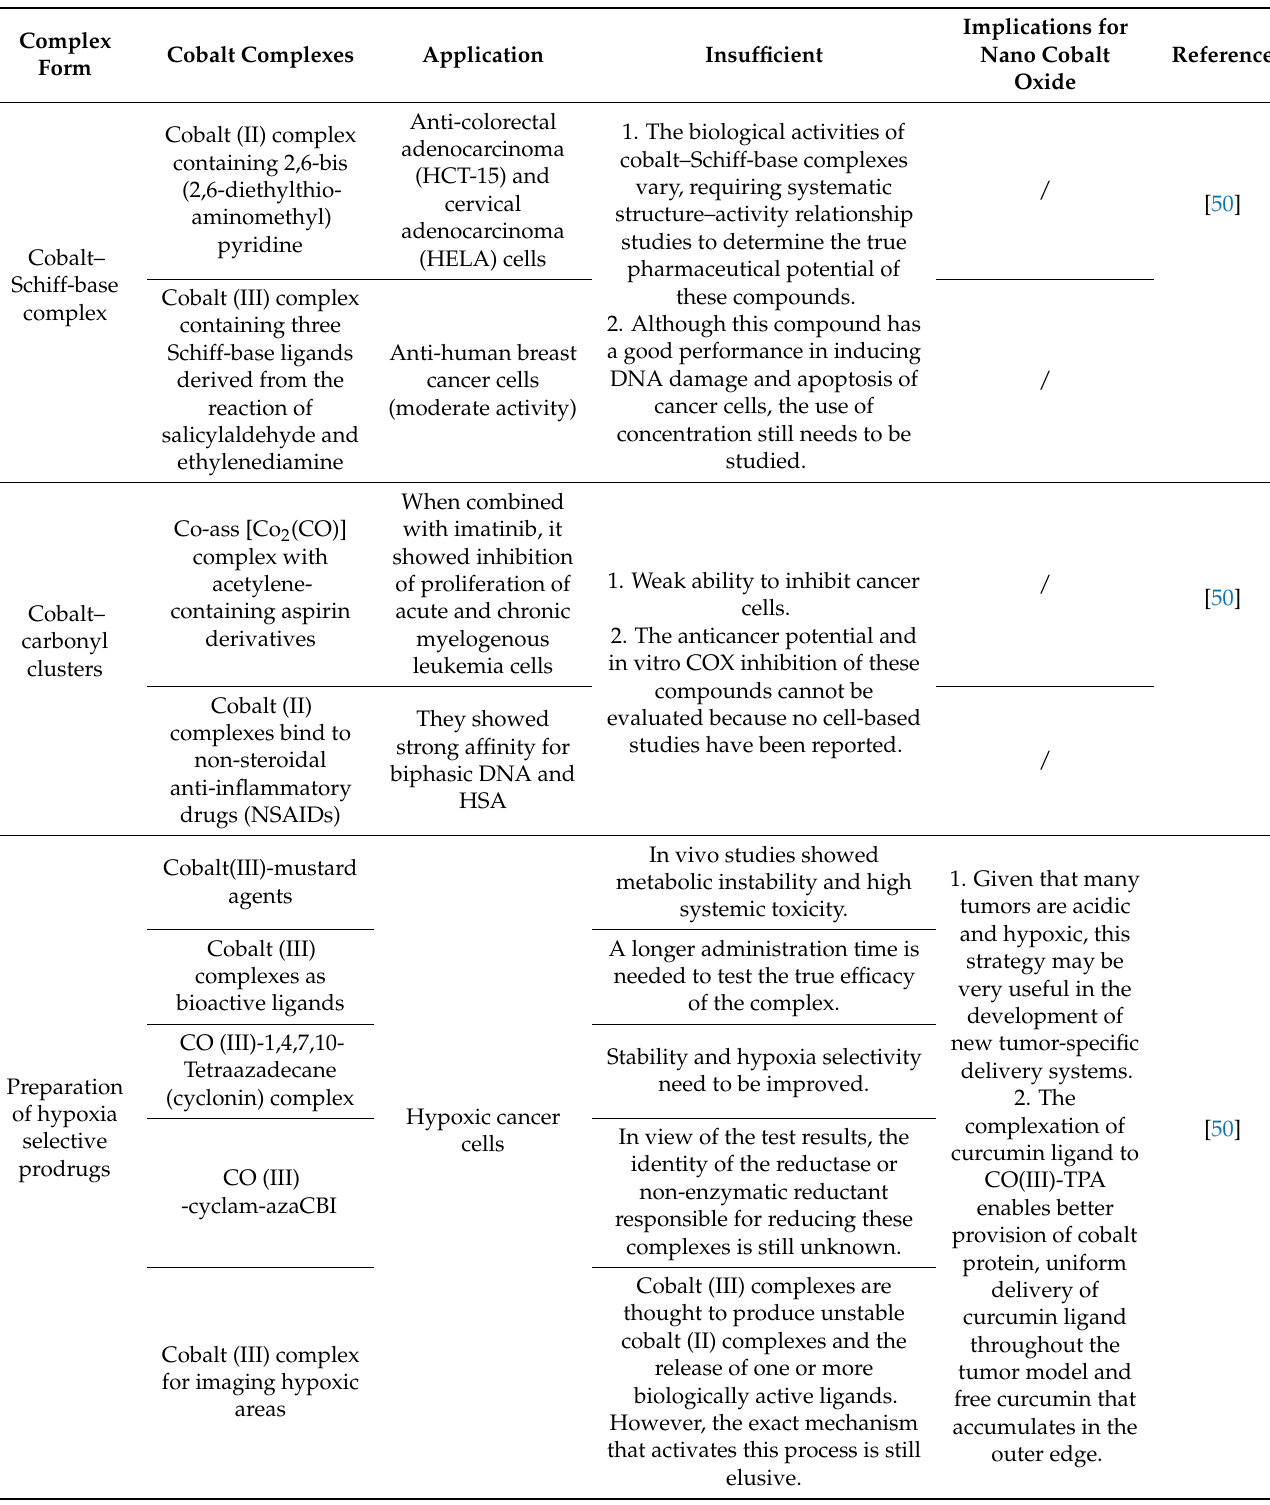
Table 2. Summary of the application of cobalt oxide